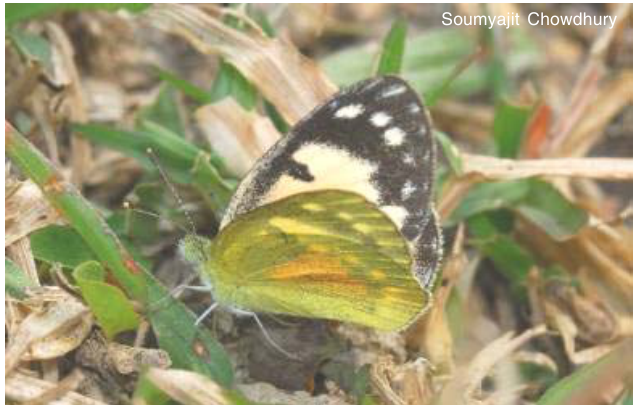
Image 2. Small Salmon Arab male showing underside. photographed in Piyali, 7 December